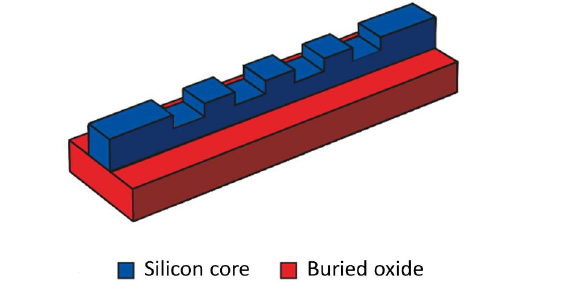
Fig. 4. Waveguide Bragg mirror after the etching process. The silicon core is shaped to obtain a periodic discontinuity of the refractive index. In this conceptual view the upper cladding of 100 nm thickness is not drawn, but it is present in all the simulations.